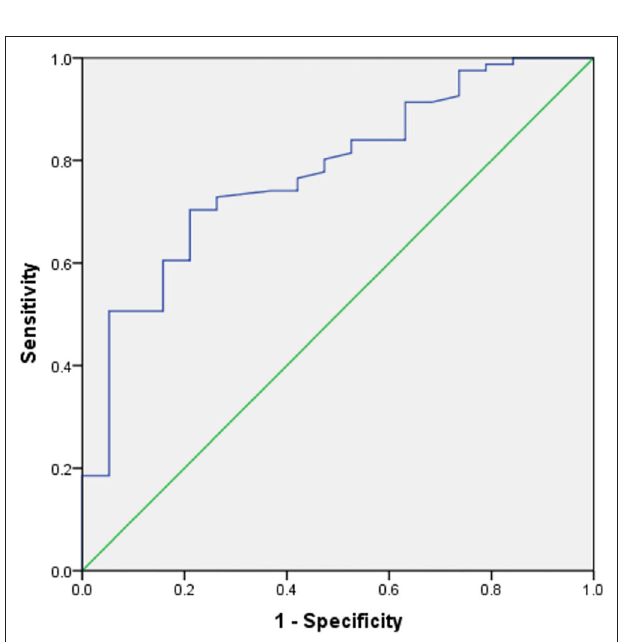
in the production, storage, and secretion of insulin by islet β - cells, and protects vascular endothelial integrity via its anti- oxidative, anti-apoptotic, and membrane stabilizing effects (19). In addition, Mg plays an important role in glucose homeostasis and the maintenance of insulin bioactivity